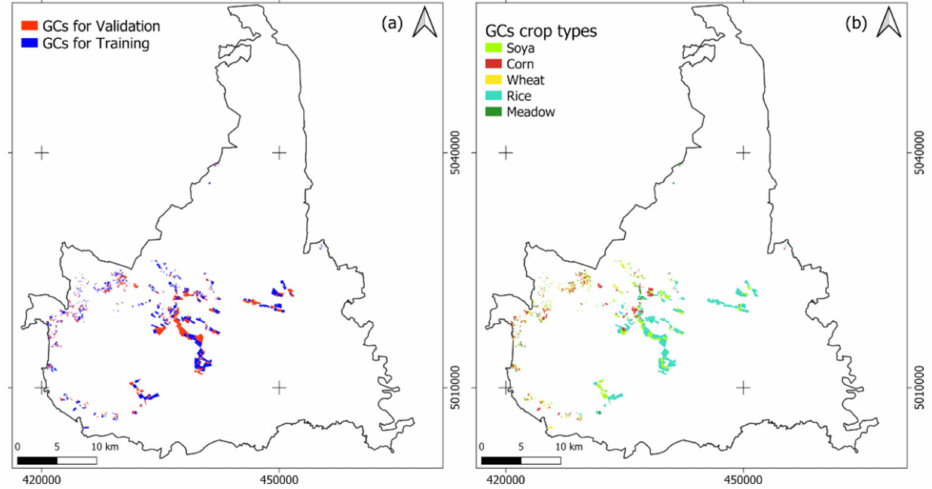
Figure 3. ( a ) GCs used in the training and validation phase. ( b ) GCs crop types (reference system is WGS84/UTM 32N, EPSG: 32632). Table 2. Number and size of the surveyed plots carried out by ARPEA per crop type and relative split of GCs involved in TP and